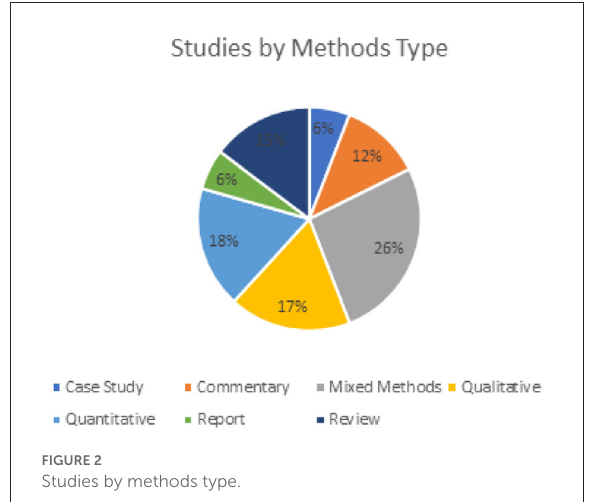
FIGURE3 Geographical distribution of